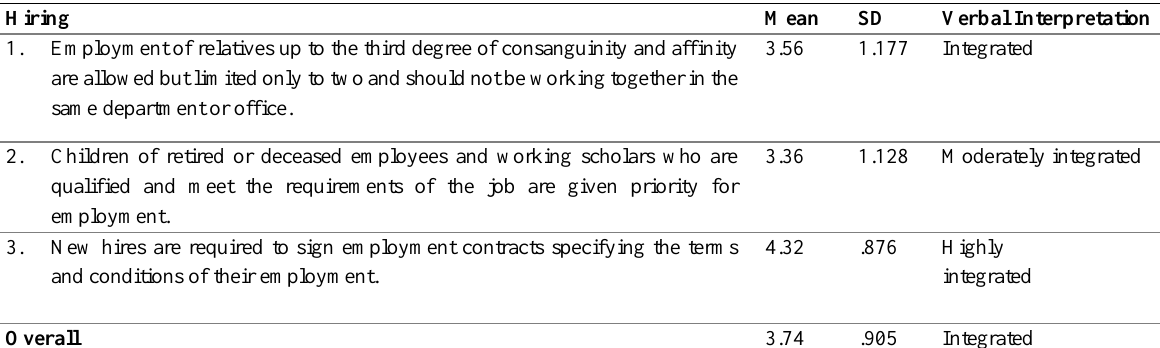
Table 7: Extent of Integration of Social Responsibility to the Hiring as Perceived by Respondents Hiring Mean SD Verbal Interpretation